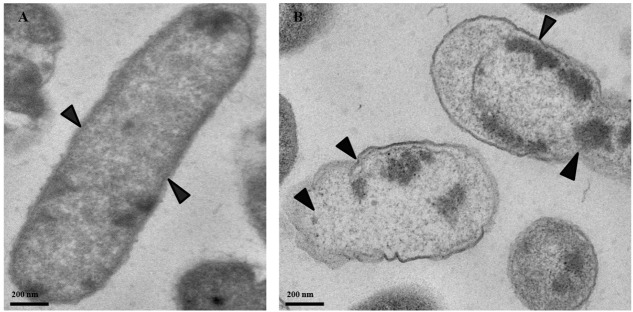
Micrographs of P. carotovorum cells examined with transmission electron microscopy (TEM). Bacteria were incubated in nutrient broth medium (NB) without potassium tetraborate tetrahydrate (PTB) (A) or with 100 mM PTB (B). In the absence of borate, the cytoplasm and cell membranes were intact and appeared normal (A; black arrows). Following treatment with 100 mM PTB the cell membranes were degraded, the cytoplasm exuded from damaged areas and cell structure was abnormal (B; black arrows).